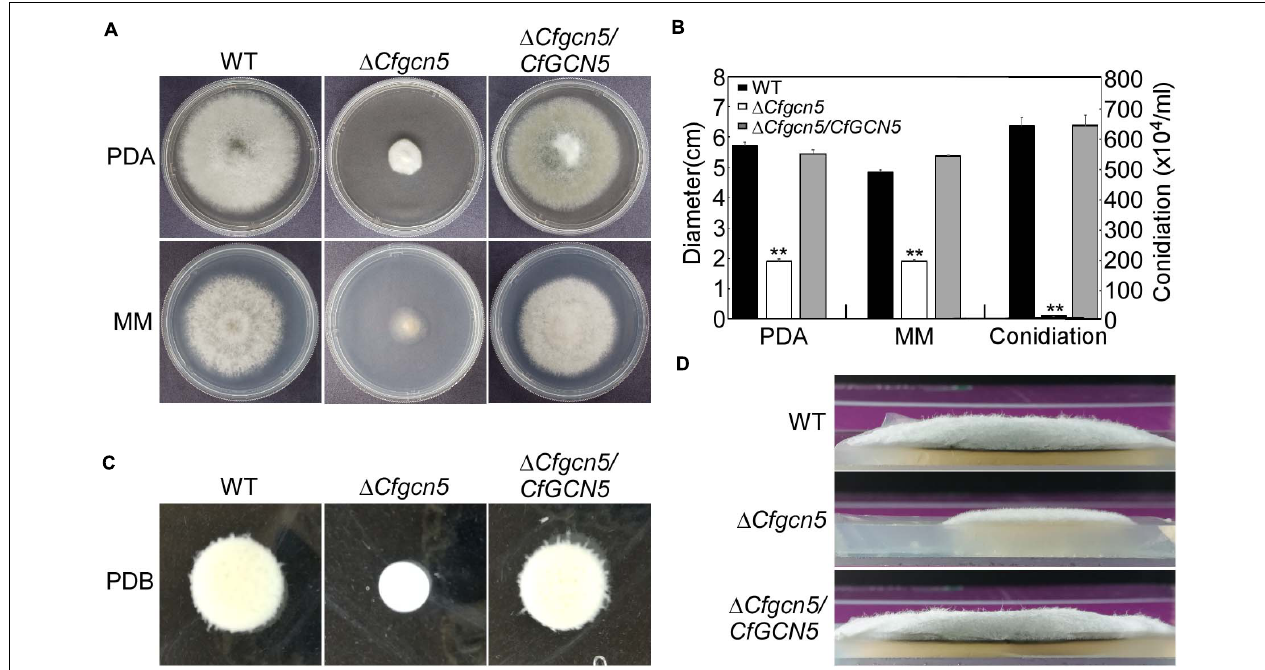
FIGURE 2 | CfGcn5 is involved in vegetative growth and conidiation. (A) Growth of wide-type (WT), (cid:49) Cfgcn5 mutant, and complemented strain (cid:49) Cfgcn5 / CfGCN5 on PDA and MM plates for 4 days. (B) Colony diameters and conidia were measured and statistically analyzed by Duncan analysis. Asterisks indicate significant differences ( p < 0.01). (C) Mycelial growth following incubation in liquid PDB for 2 days. (D) Aerial hyphae growth is observed. Strains were cultured in PDA plates for 4 days and colony side views are